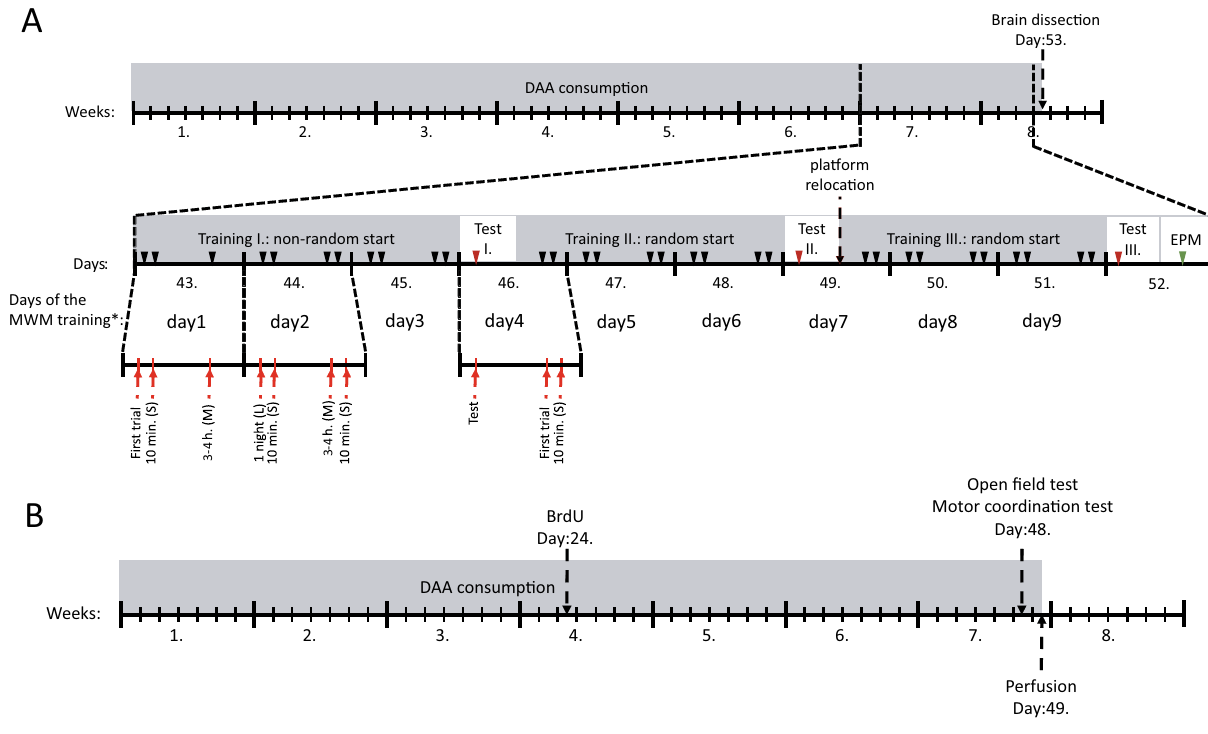
Figure 1. Graphical illustration of the experimental timeline of two cohorts of mice: ( A ) In Experiment 1, spatial learning ability of the mice was assessed using MWM test from day 43 to day 51. Black arrowheads denote the training trials while red arrowheads show the test trials (where the platform was not present). Red arrows represent the time position of trials within a day, along with the preceding intertrial intervals (trial types: M, L or S). EPM elevated plus maze test, *days of the MWM training as shown on Fig. 2. ( B ) In Experiment 2, BrdU was injected on day 24 of DAA consumption to label proliferating neurones. One day before perfusion open field test followed by a motor coordination test (rod grip test) were carried out on all experimental